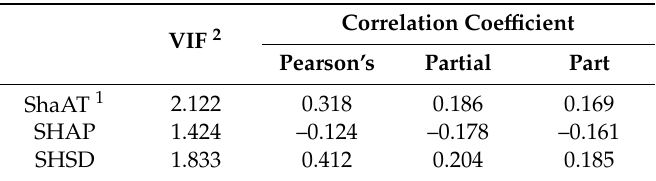
Table 4. Multicollinearity statistics for climatic variables used for the sorghum–sudangrass hybrid yield modeling.